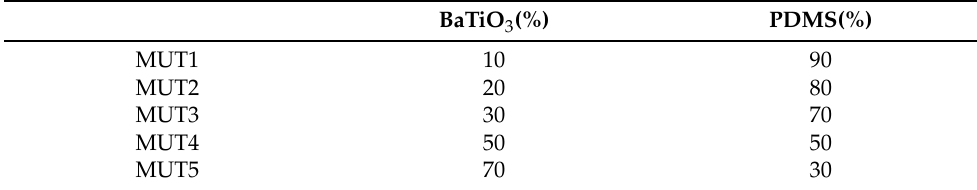
Table 1. Five different materials under tests (MUTs) were investigated. Each has different BaTiO 3 content from 10% to